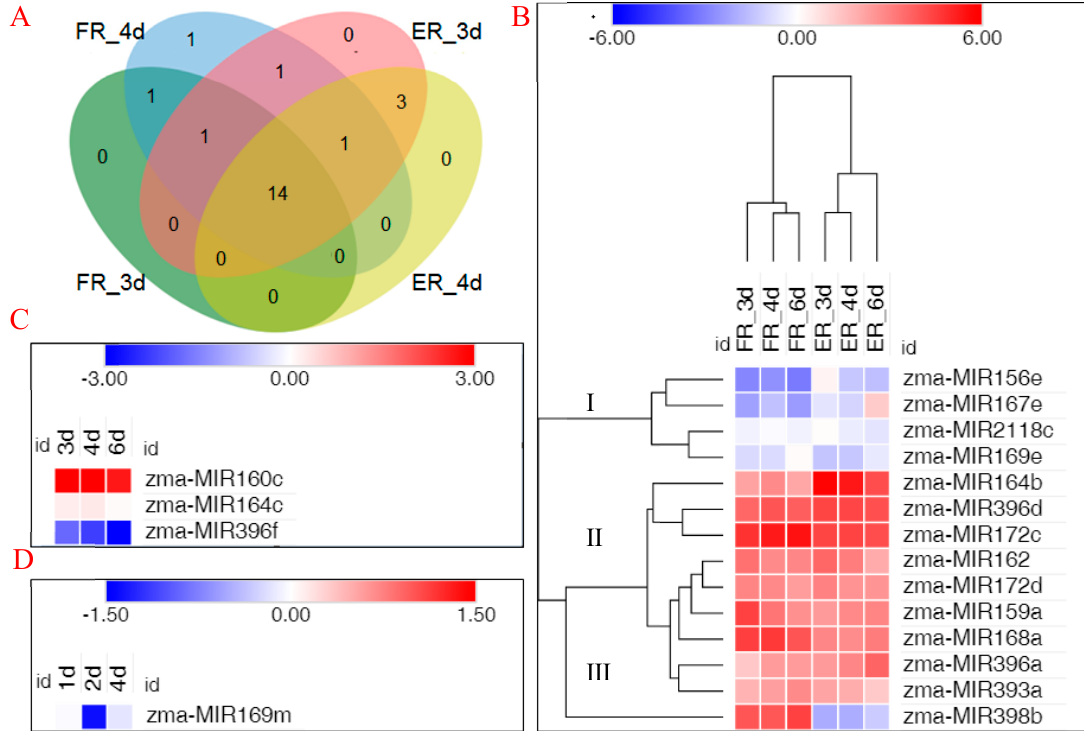
Figure 2. Distribution of microRNAs (miRNAs) at different stages of internode elongation. Comparison of miRNAs identified between fixed internode region and elongation area. ( A ) Venn diagram of miRNAs associated with internode elongation at FR and ER after nine leaves of maize were unfolded. The 1 cm region of seventh fixed node top and the 1 cm (elongation) region of ninth elongating node base are denoted as FR and ER, respectively. ( B ) Temporal patterns of microRNA expression in both fixed and elongating internode samples. ( C ) miRNAs specifically expressed in the elongating internode samples; ( D ) microRNAs specifically expressed in the fixed internode samples. The color bars show log2 FPKM (fragments per kilobase per million reads). FR, seventh fixed internode region; ER, ninth elongating internode region; 3d, 4d, or 6d, the third, fourth, or sixth day after the ninth spreading leaf. The data are presented in Supplementary Tables S2 and